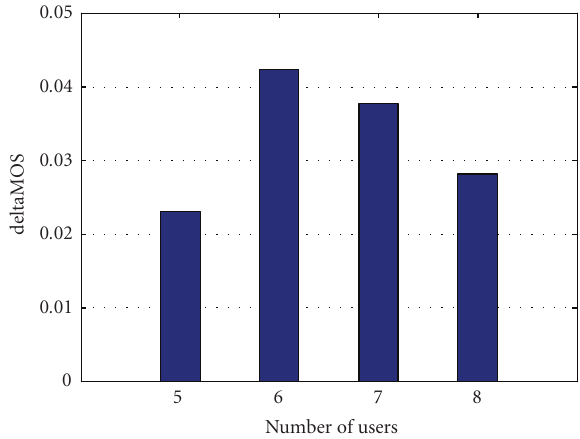
Figure 16: Worst-case di ff erence in MOS (deltaMOS) between full- search and greedy algorithm.